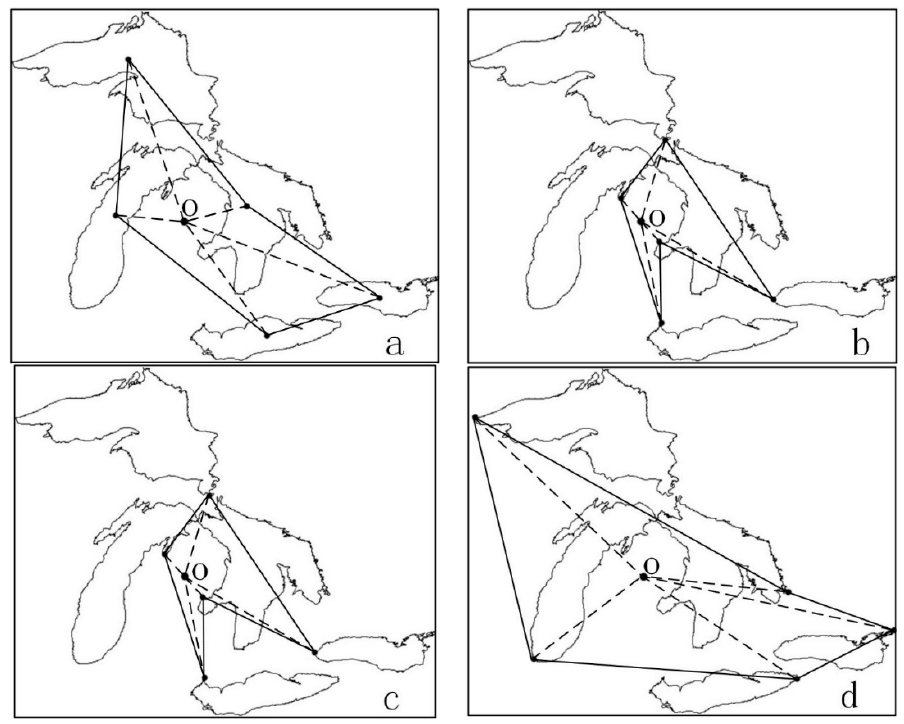
Figure 13. Position graphs of the Great Lakes in 2015. ( a ) CPPG in 2015; ( b ) NTPPG in 2015; ( c ) NPPG in 2015; and ( d ) FPPG in 2015.